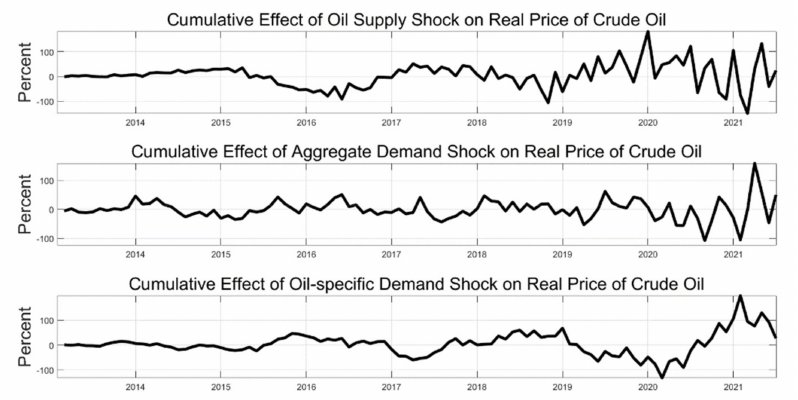
Figure 1. The cumulative effects of crude oil price shocks. From top to bottom, figures plot the cumulative effects of the oil supply shocks, aggregate demand shocks, and oil-specific demand shocks on the real WTI oil spot price, respectively. The data span from February 2013 to June 2021. The cumulative impacts of three oil price shocks on oil prices are